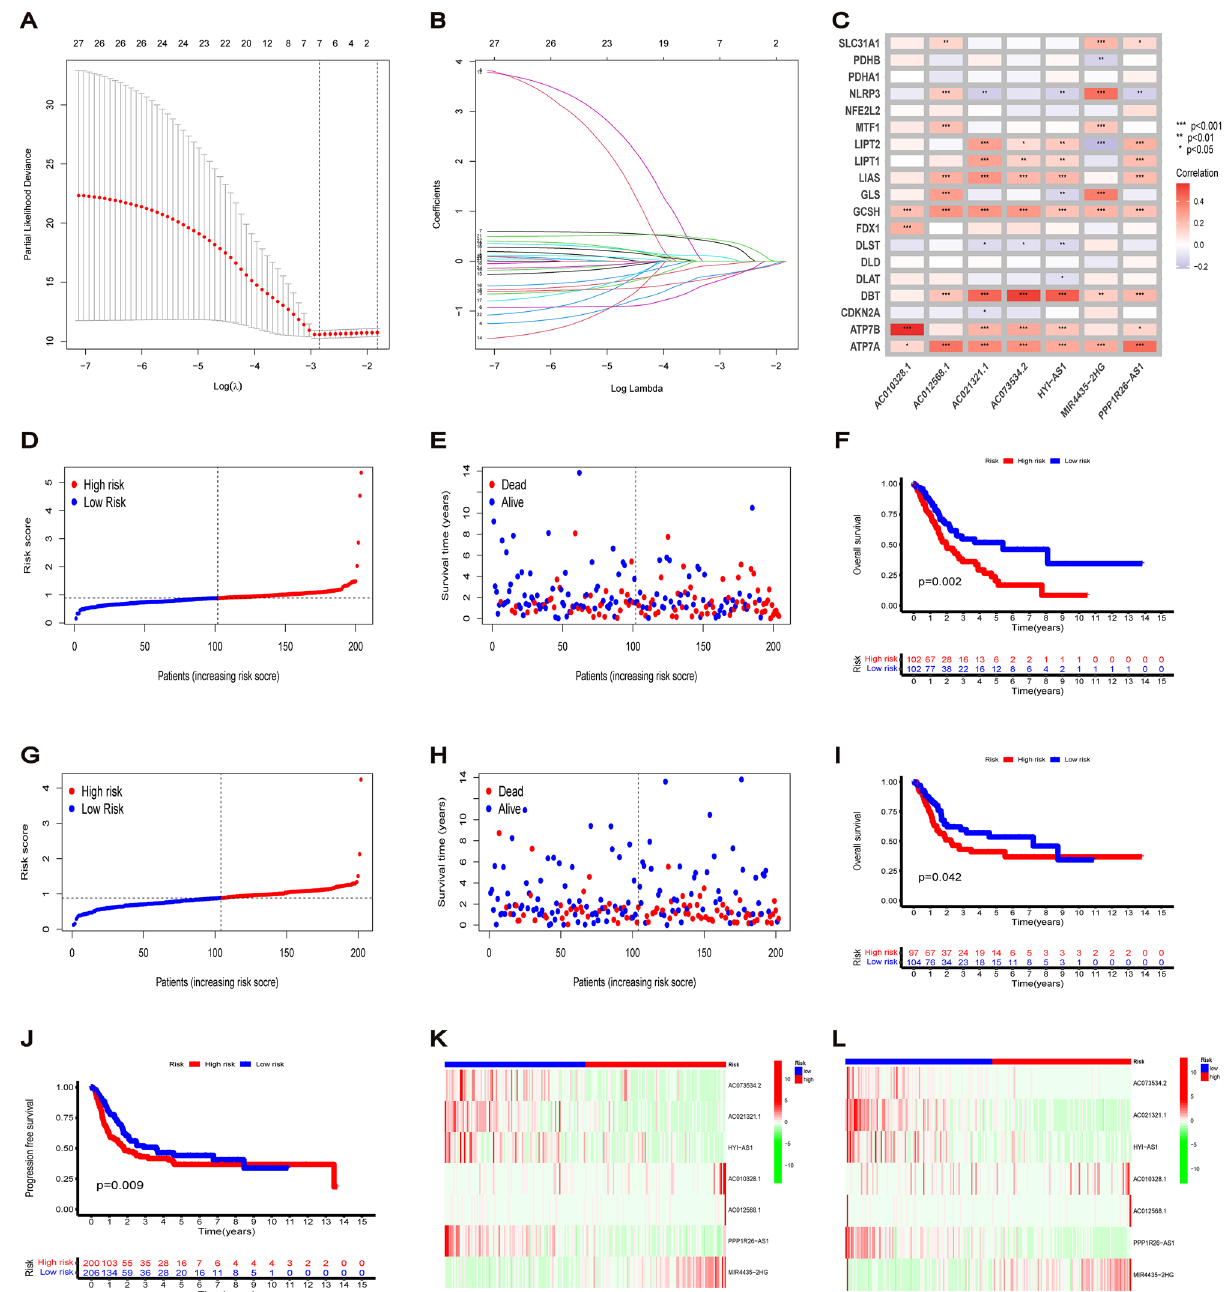
Figure 4. Construction of prognostic signature for cuproptosis-related lncRNAs. ( A ) The tenfold cross- validation for variable selection in LASSO regression for the training group cohort. ( B ) 7 lncRNAs and their coefficients were determined by LASSO algorithm. ( C ) The heatmap of the correlation between cuproptosis gene and lncRNAs. ( D , G ) BC patients in train and test cohort divided into low-risk and high-risk subgroups according to the median risk score. ( E , H ) The survival status of each patient with different risk in train and test cohort. ( F , I ) Kaplan–Meier curves of OS in different risk groups of train and test cohort. ( J ) Progression free survival for the overall sets between high-risk group and low-risk group ( K , L ) The heatmap of 7 cuproptosis- related lncRNAs with different risk subgroups in train and test